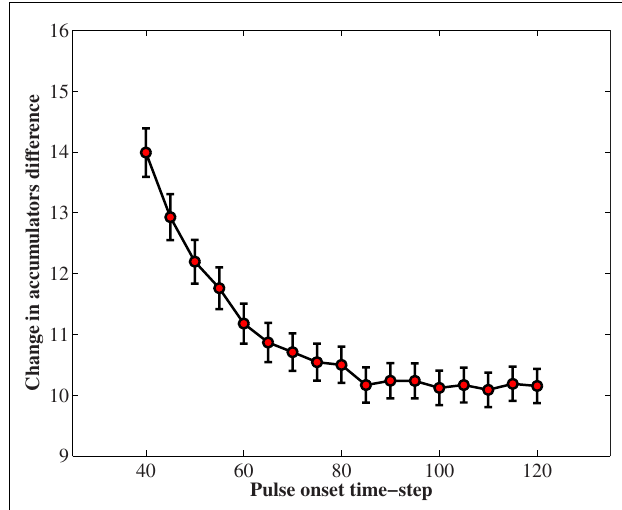
FIGURE 9 |The effect of a short pulse on the activation states of two leaky competing accumulators, at different times in the trial. Each trial lasted for 200 time-steps.The two accumulators received Gaussian inputs with mean and standard deviation both equal to 1.The pulse was inserted for 40 time-steps and increased the mean input to the target accumulator by 1 unit. In the y -axis we plot the change that the pulse conferred to the difference between the target and the non-target accumulator.The change is calculated by subtracting the difference between the accumulators’ activity 40 time-steps after the offset of the pulse minus the activity difference at the onset of the pulse.The effect diminishes as the time of the pulse onset increases.The leaky competing accumulator model was simulated with inhibition three times larger than the leakage ( β = 0.15, k = 0.05). Error bars correspond to 95%